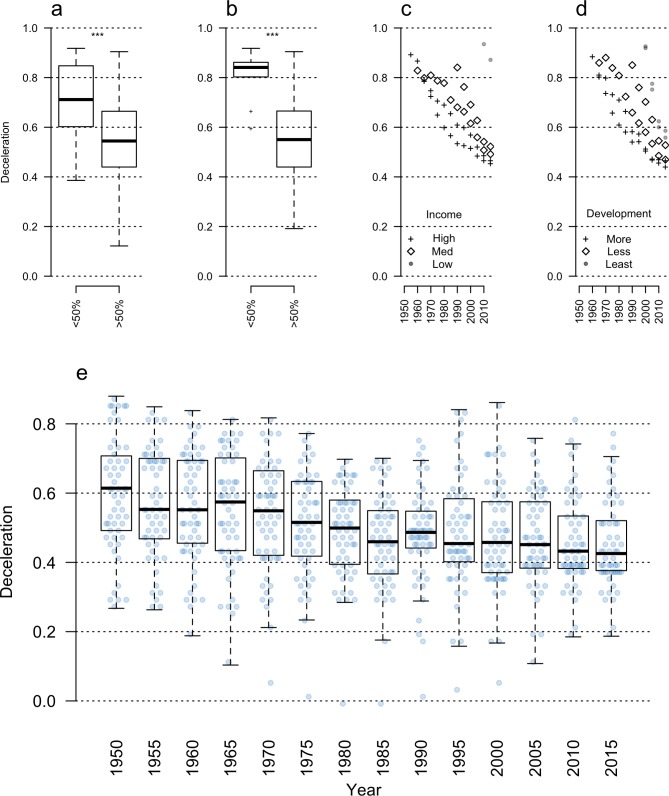
Reduced LLMDs in populations with better population data and higher vital statistics coverage.The rate of LLMD (y-axis) is linked to differences in (a) the fraction of the population with death certificates, (b) the fraction of the population with birth certificates, (c) per capita gross domestic product, and (d) levels of population development (Bonferroni-corrected pairwise t test; asterisks indicate p < 0.001). In populations with continuous records of late-life mortality (e), mortality deceleration rates have fallen by 25% since 1950, alongside gains in civil registration rates (N = 55). Underlying data can be found in S3 Data. LLMD, late-life mortality deceleration.